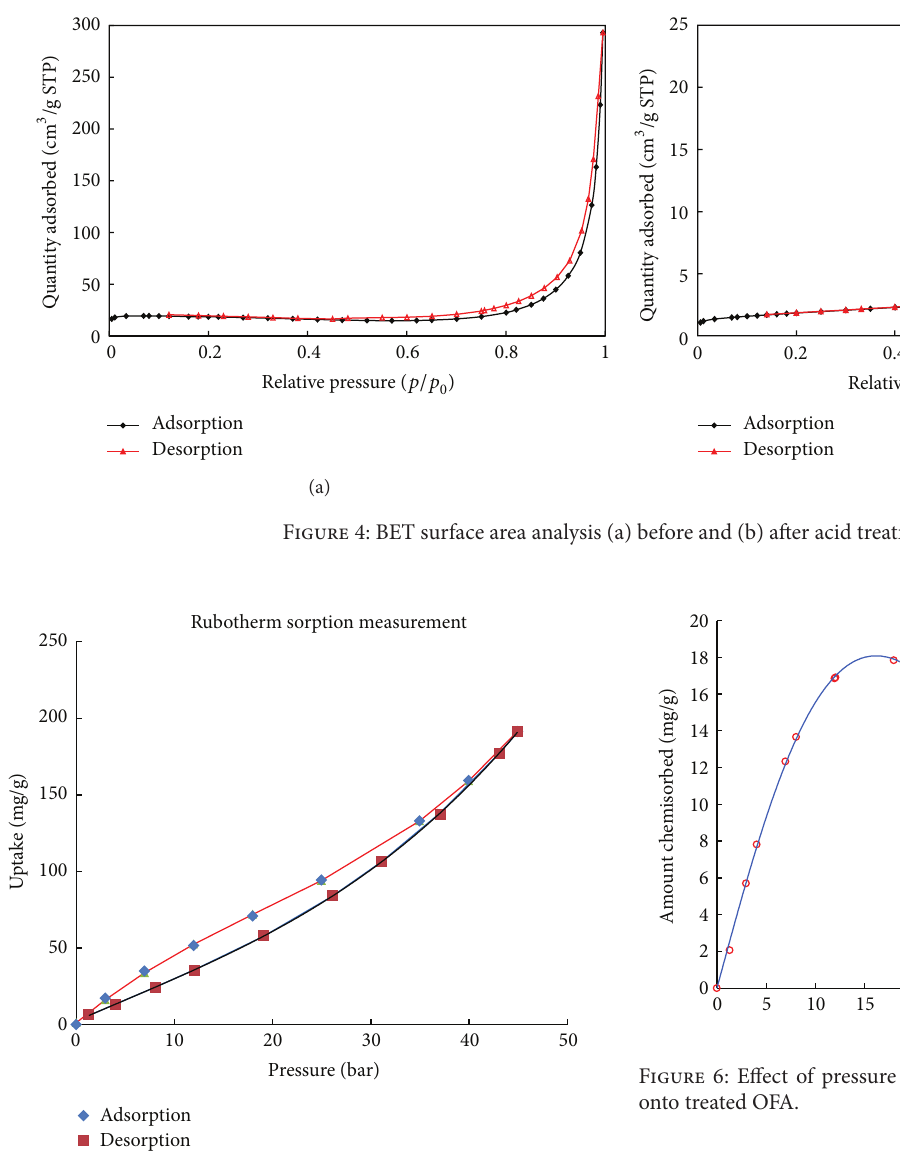
Figure 5: CO 2 equilibrium isotherm over treated OFA.